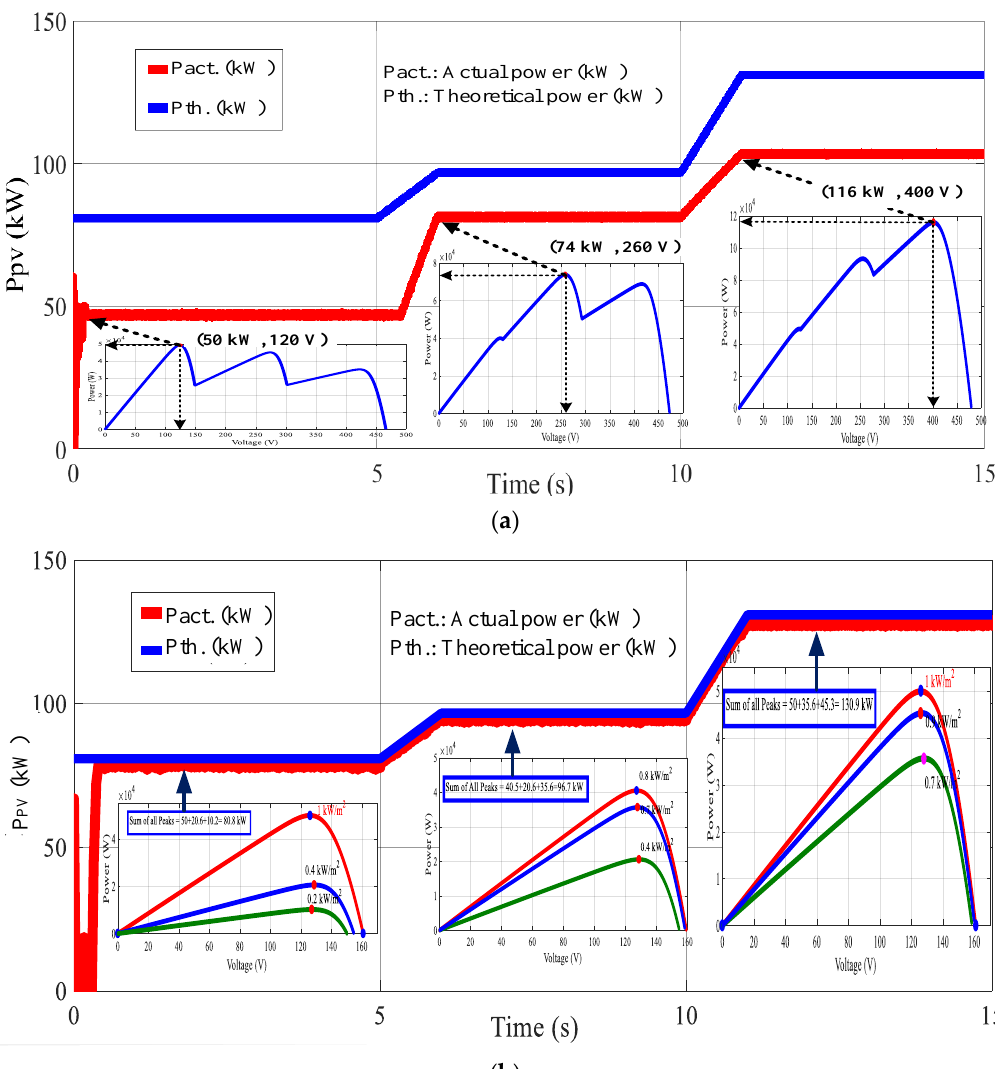
Figure 9. The maximum power available from the PSPV: ( a ) With CBC; ( b ) With IBC.